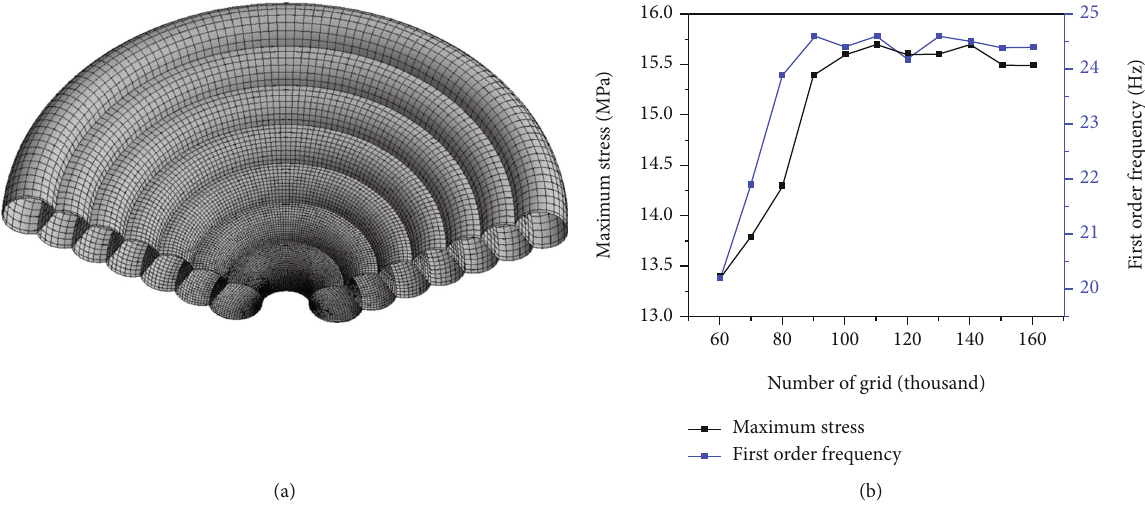
Figure 3: Finite element model and grid independence validation: (a) fi nite element model; (b) grid independence